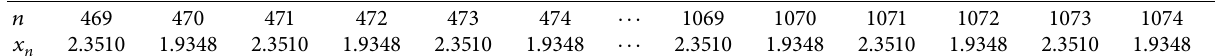
Table 2: Te partial value of the solution of equation (27) with the initial values (28).